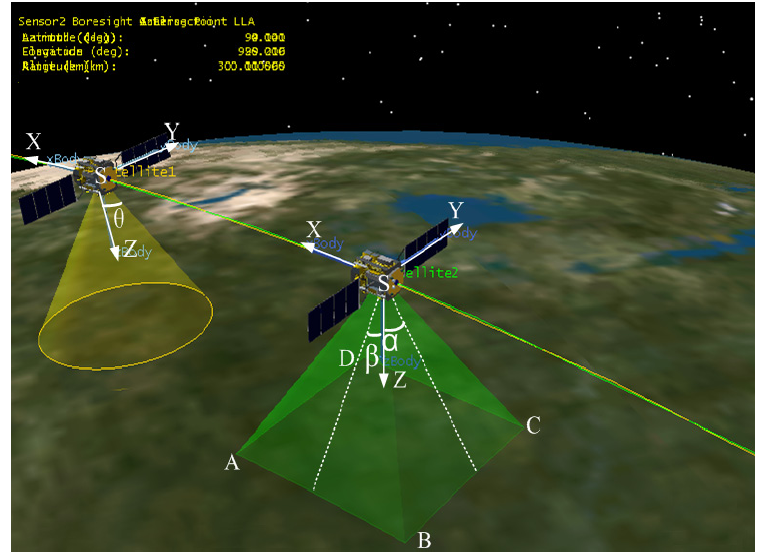
Figure 13. Sensor plan and data acquiring based on the pre-defined